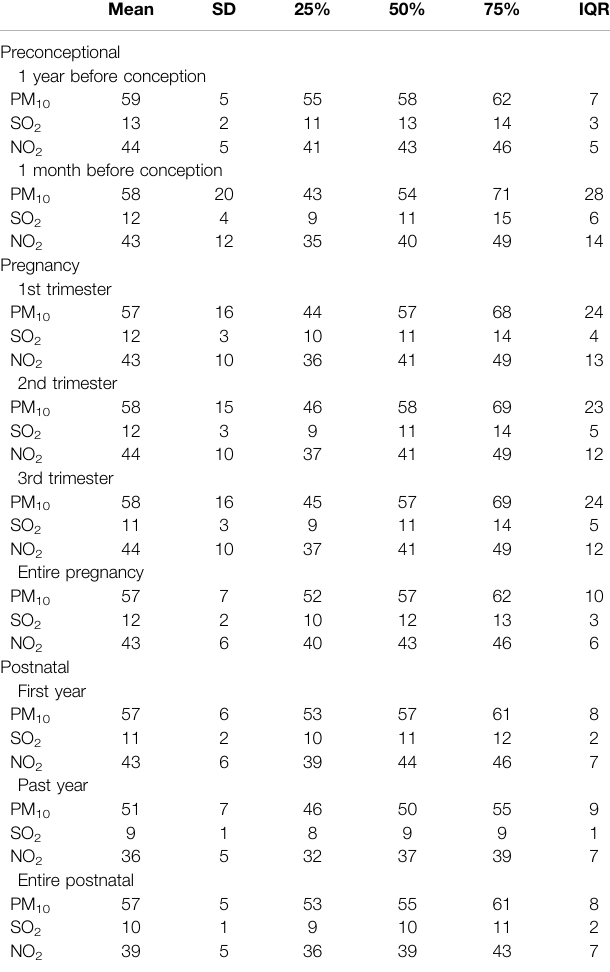
TABLE 1 | Statistics of being exposed to outdoor air pollution during preconceptional, prenatal, and postnatal periods among children aged 3 – 6 years ( n =